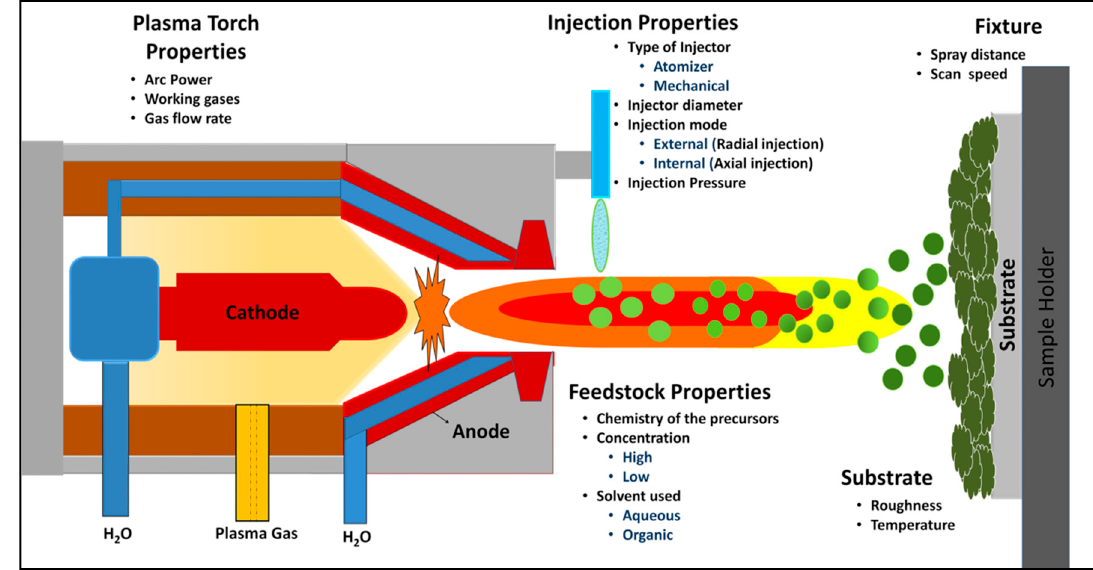
Figure 2. Schematic diagram of the solution precursor plasma spraying process showing the many different and important operational spray parameters that could influence the physical and chemical characteristics of cermet coatings.